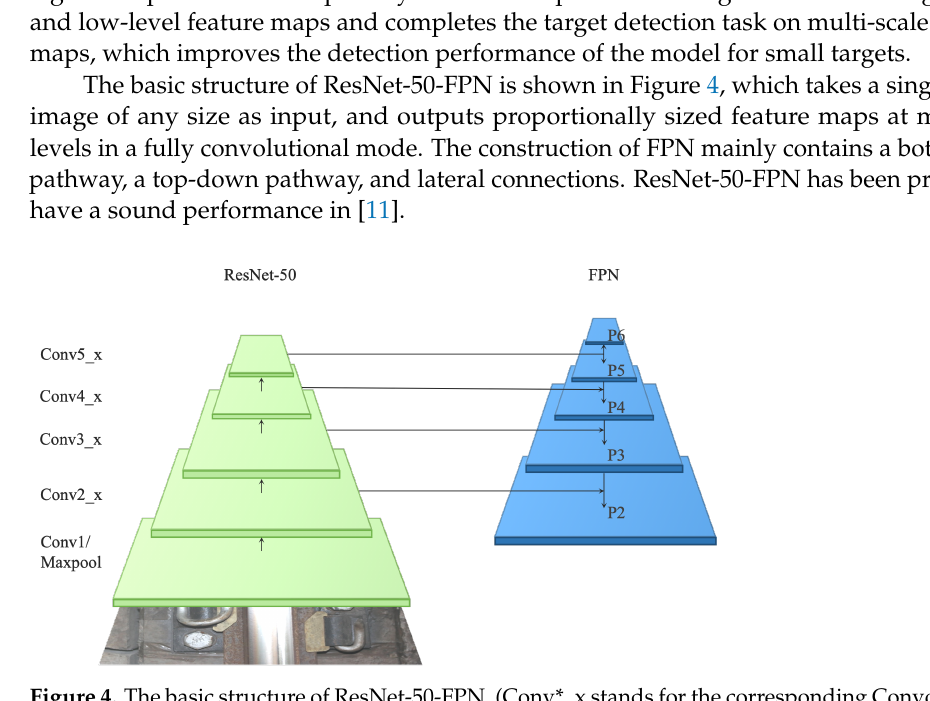
Figure 4. The basic structure of ResNet-50-FPN. (Conv*_x stands for the corresponding Convolutional layer in